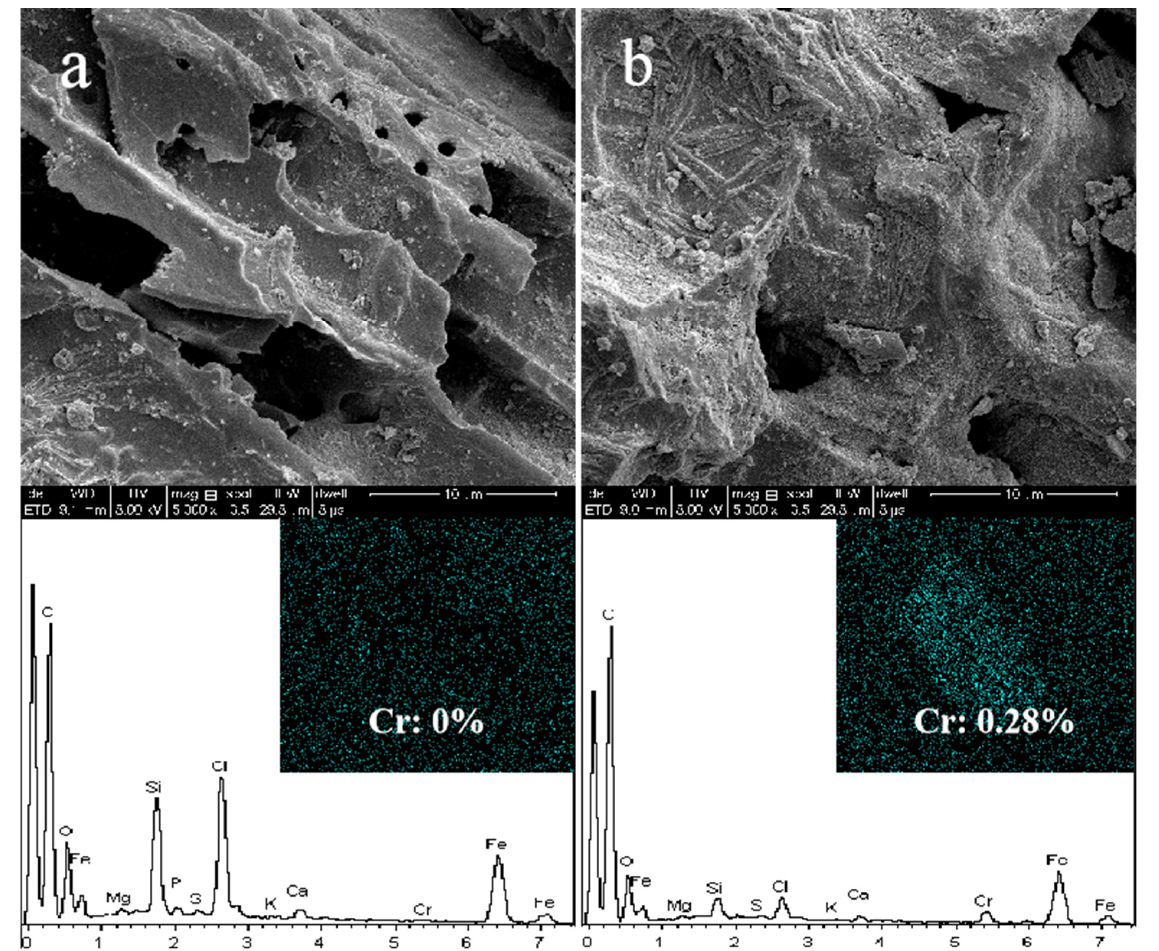
Figure 5. SEM- EDS analyses of FeCl 3 @BC before reaction ( a ), after reaction ( b ). Figure 5. SEM-EDS analyses of FeCl 3 @BC before reaction ( a ), after reaction ( b